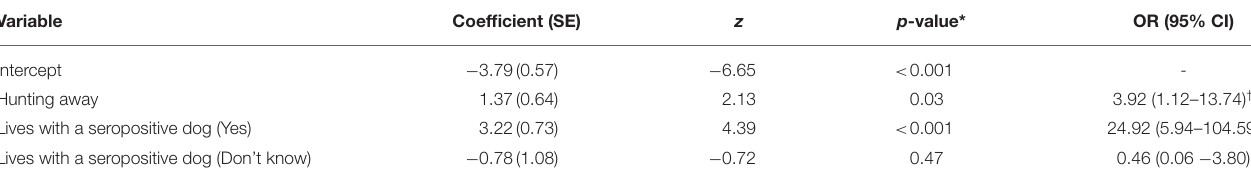
TABLE 6 | Estimated regression coefficients and their standard errors from a logistic regression model of risk factors for Brucella suis seropositivity in at-risk